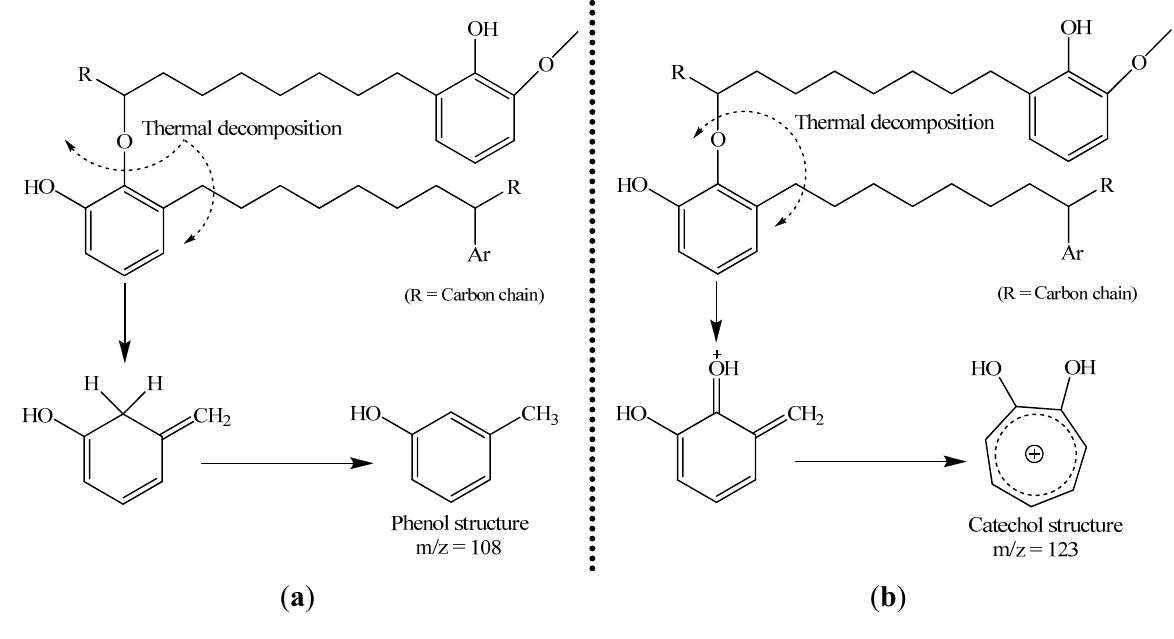
Figure 5. Phenol ( a ) and catechol ( b ) structures produced by thermal